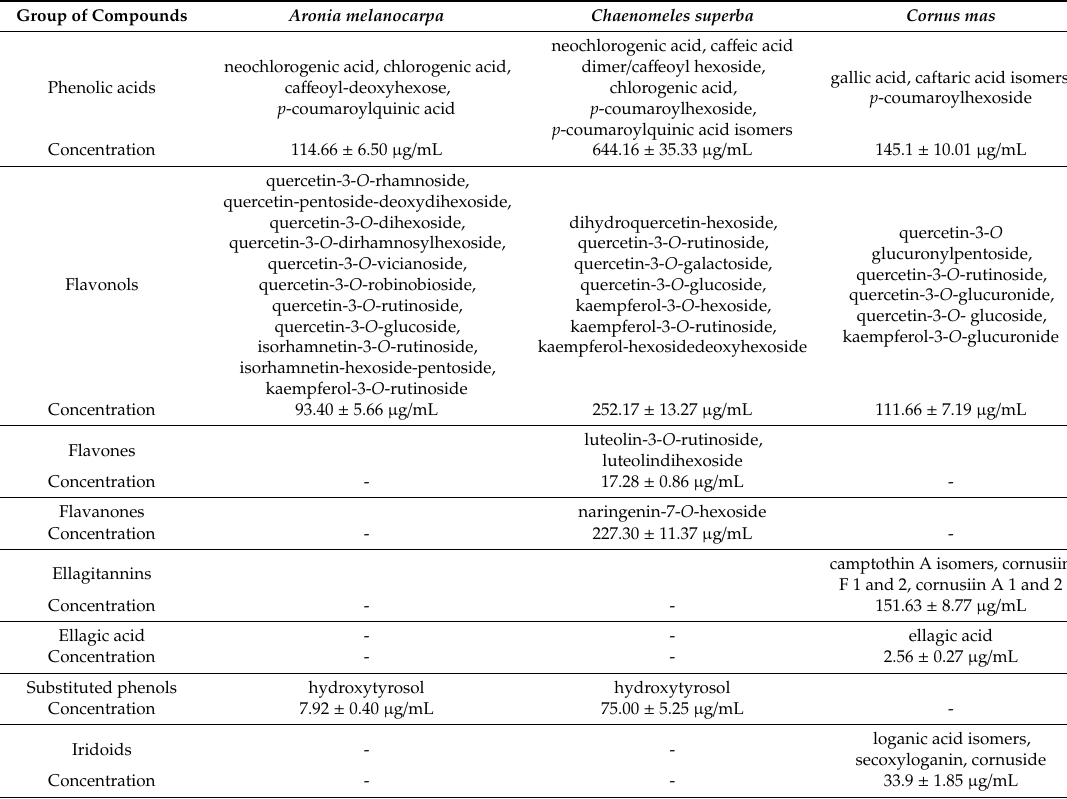
Table 1. Composition of Aronia melanocarpa , Chaenomeles superba , and Cornus mas leaf extracts [14]. Group of